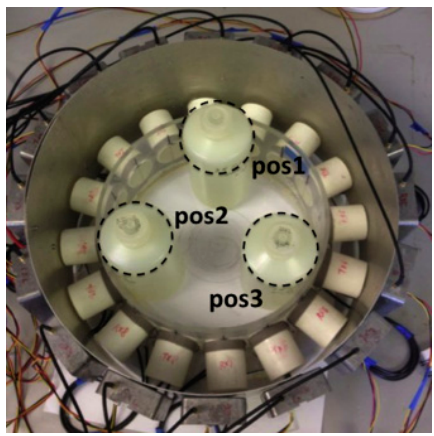
Figure 2. Photo of the 16-channel MIT measurement setup for saline bottle detection [84].